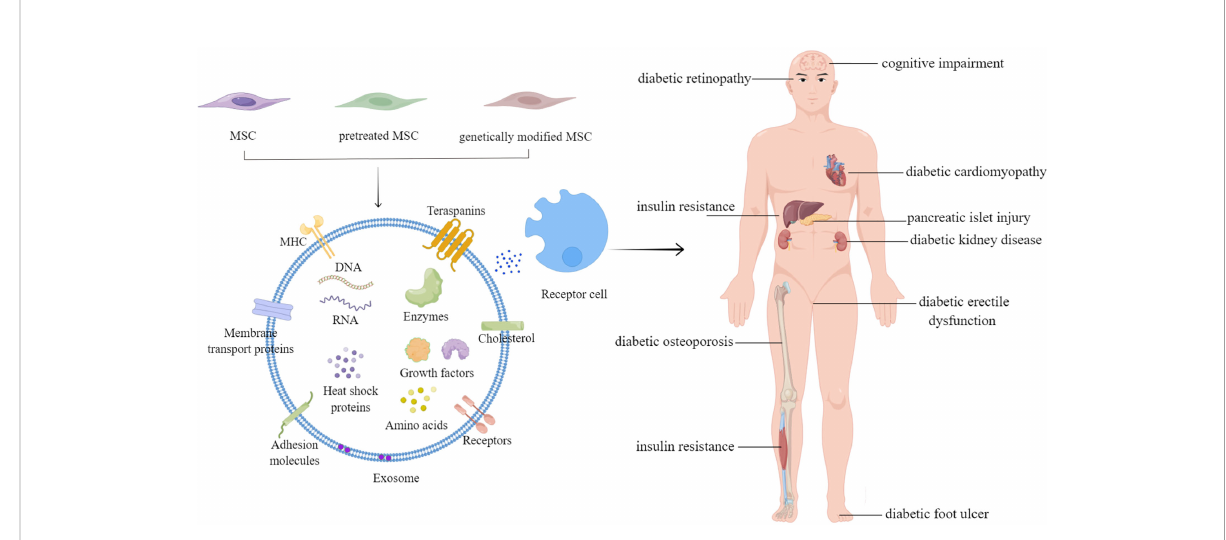
FIGURE 1 The applications of mesenchymal stem cell-derived exosomes in diabetes mellitus and related